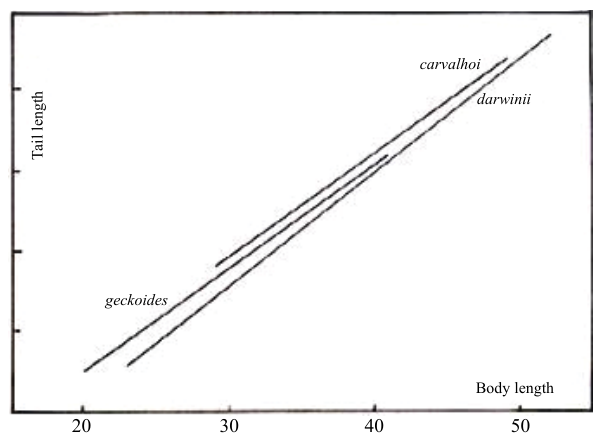
Graph 4 – Gymnodactylus, Regression of tail length on body length. Interspecific